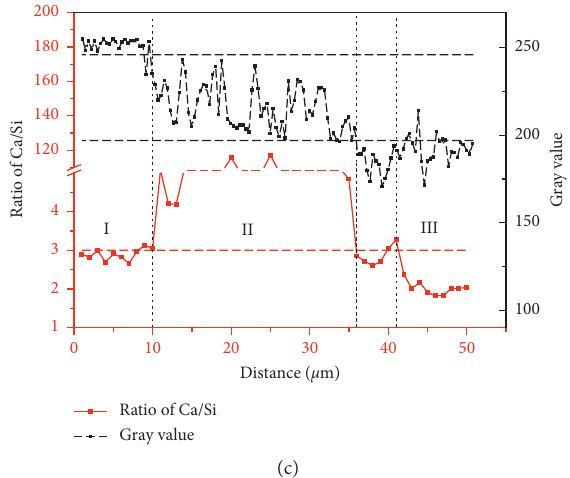
Figure 12: Corresponding map of BSE gray distribution and EDS. (a) The original line scan. (b) Postproduction, in order to facilitate observation and analysis. (c) The map of Ca/Si and gray value.